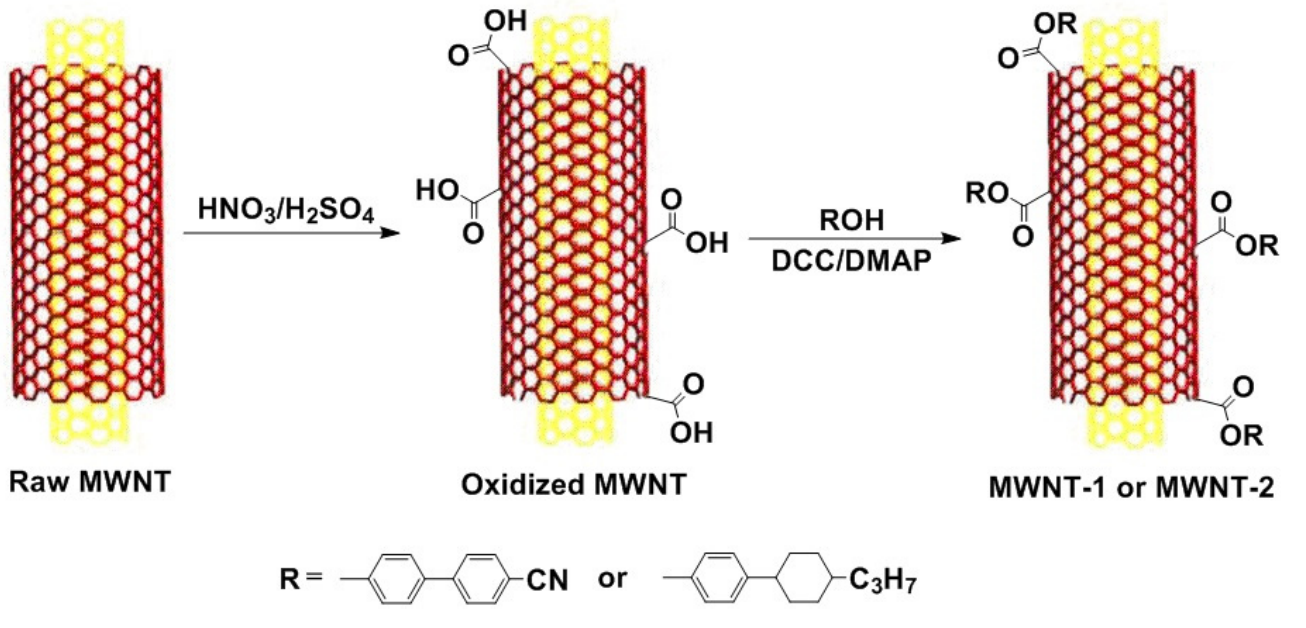
Figure 1. The chemically modified synthetic routes of MWNT-1 and MWNT-2.